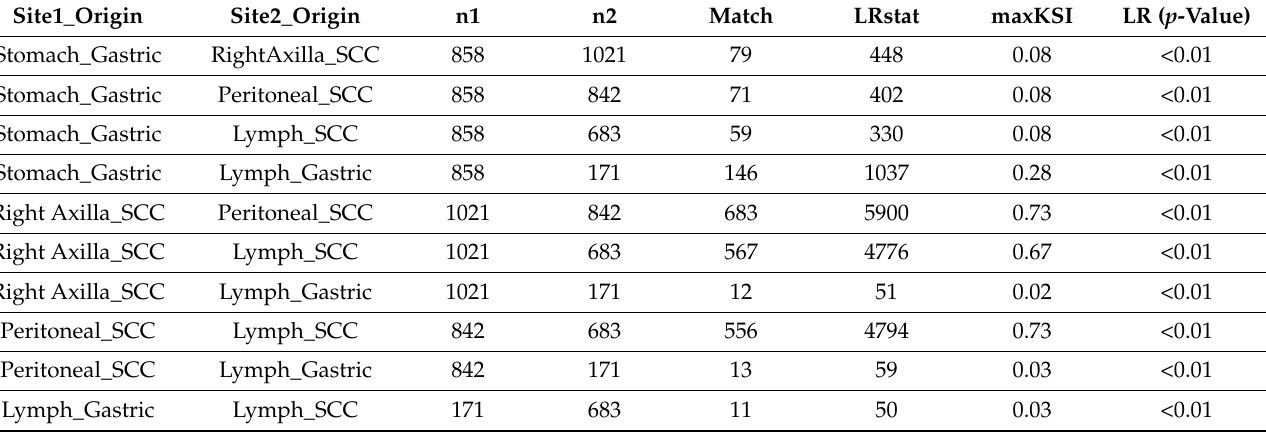
Table 2 Legend: In Table 2, each row contains the result of a pairwise comparison of somatic SNV profiles utilizing the SNVtest module of the Clonality R package [16]. Comparisons are ordered by tumor collection dates. Dates are listed in Table 1. n1 = somatic alterations identified for site 1. n2 = somatic alterations identified in tumor site 2. Match = number of matching alterations between two sites. LRStat = likelihood ratio statistics. maxKSI = clonal strength between tumor sites. Note for interpretation: while there is high clonal relatedness between tumor sites with similar origin, especially between the squamous cell carcinomas, as indicated by maxKSi scores of >0.5, predictions suggest clonality between all tumor sites with possibly different backgrounds, as comparisons for clonality hypothesis are p < 0.01 across all pairwise